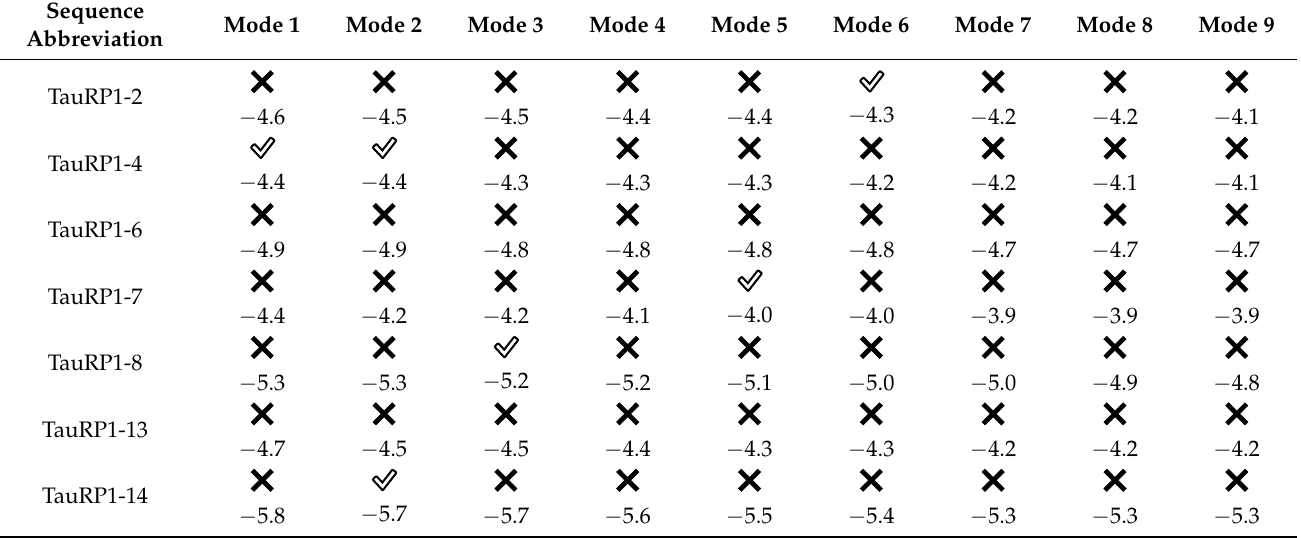
Figure 4. Results obtained from docking studies showing the best binding modes for ( a ) TauRP1-2 (mode 6); ( b ) TauRP1-4 (mode1); ( c ) TauRP1-4 (mode 2); ( d ) TauRP1-8 (mode 3); ( e ) TauRP1-4 (mode 2) with PHF Tau.